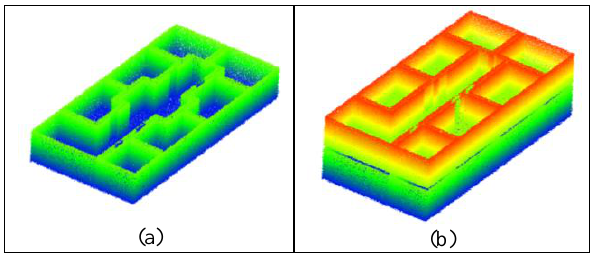
Figure 3. Simulated point cloud of the first floor (a) and the second floor (b) of a two-storey building. The ceiling is removed for better